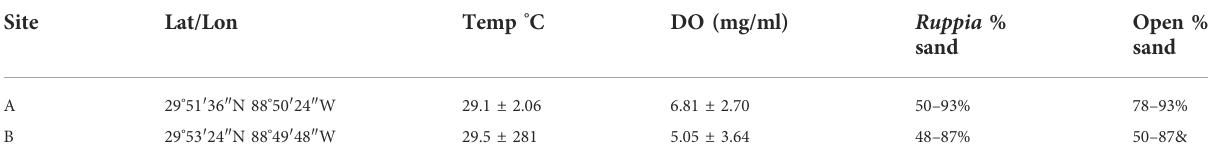
TABLE 2 Summary of environmental data for each site. Temperature and DO (means ± SD) were measured from HOBO oxygen sensors being used to measure sediment metabolism at each site (Dorgan et al. in preparation).